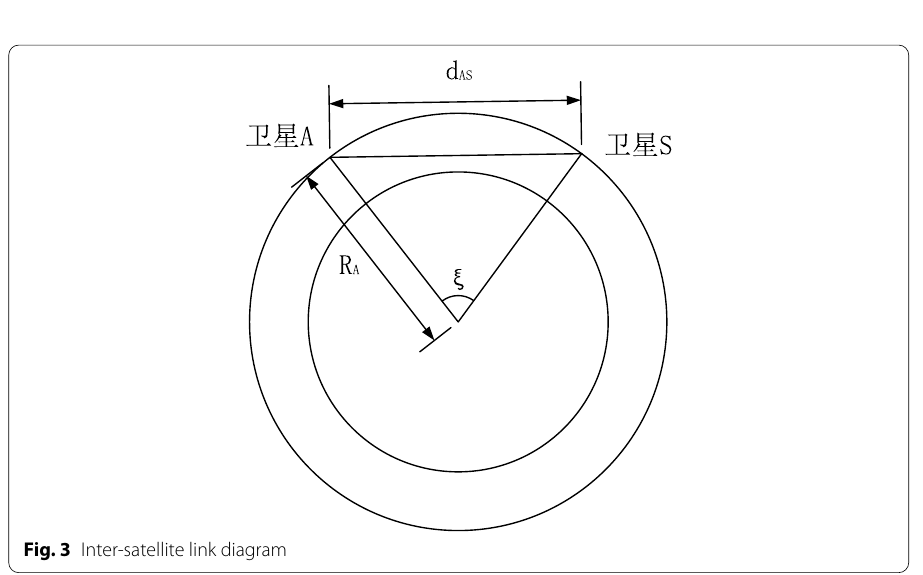
Fig. 3 Inter-satellite link